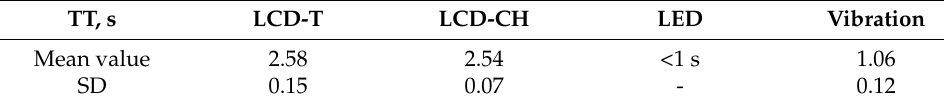
Table 5. Results of transmission time (TT) for particular